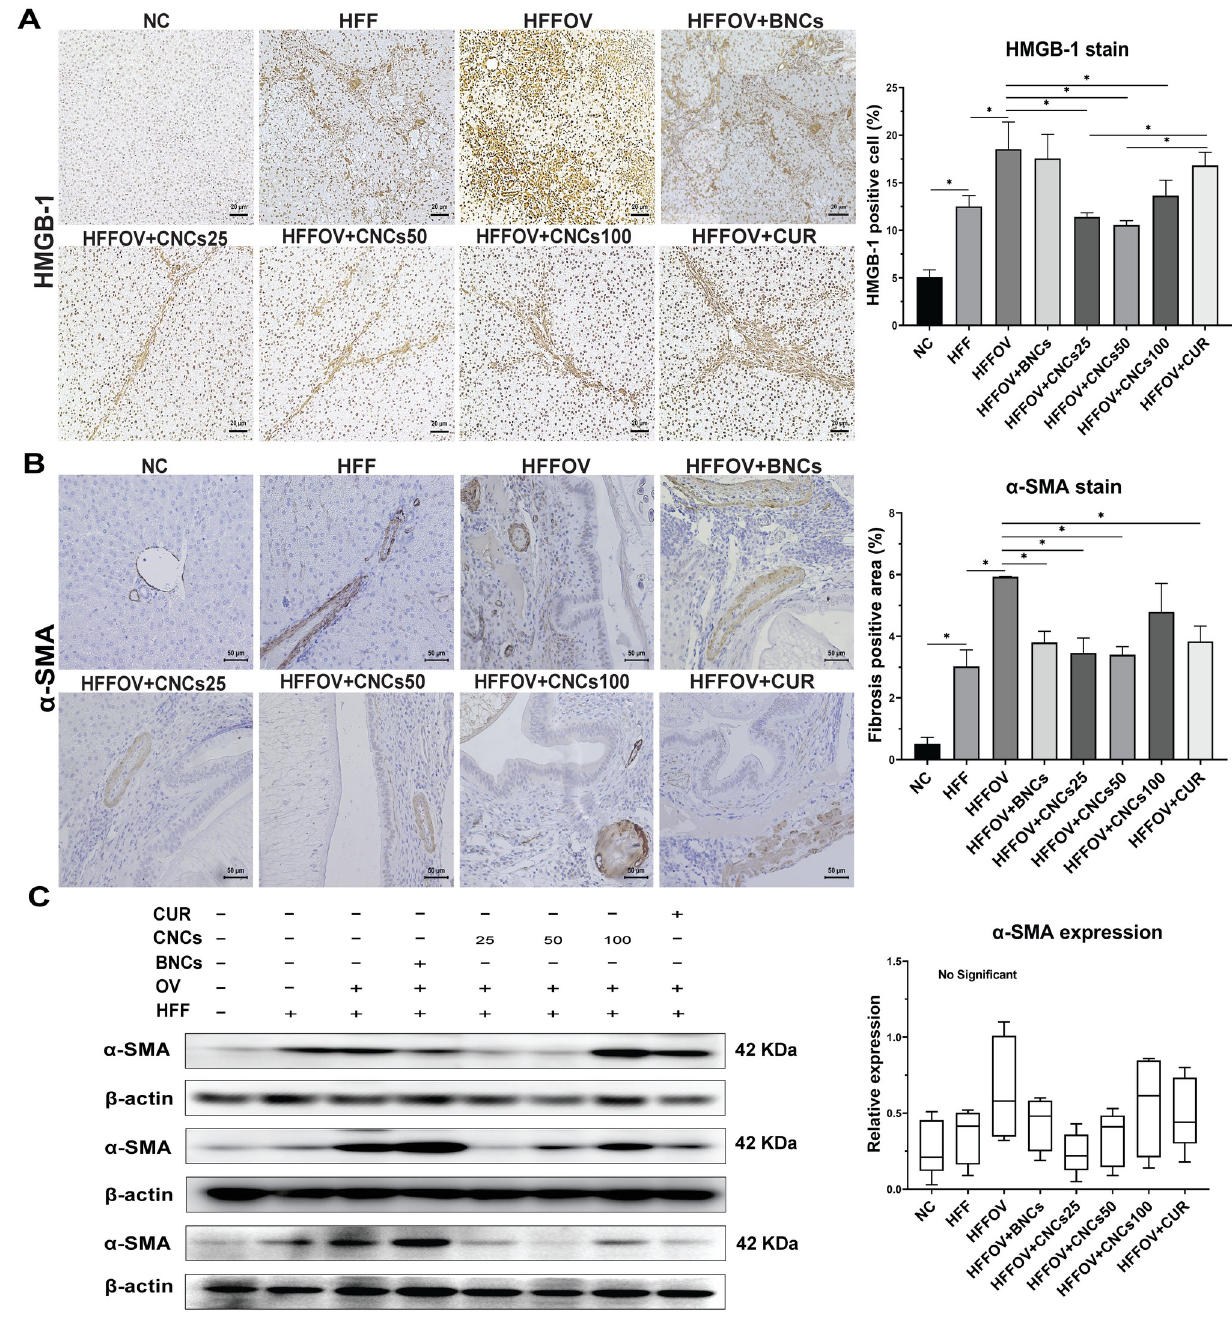
Fig 6. Effect of treatment with CNCs on inflammation and fibrosis in hamsters infected with O . viverrini and fed an HFF diet. A): Images show immunohistochemical staining (original magnification × 100) for HMGB–1 on the left and a graph of intensity of cell inflammation (assessed at 200x magnification) on the right. B): Images show immunohistochemical staining (original magnification × 200) for α –SMA on the left and a graph of intensity of cell inflammation (assessed at 200x magnification) on the right. C): Protein expression of α -SMA by western blot and quantitative analysis was normalized by β -actin from different individual hamsters. Results are presented as mean ± SD. Statistical analyses were done using one-way ANOVA � P < 0.05 (Tukey’s multiple comparisons test) (n = 4–5 in each group). Abbreviations are the same as in Fig 3 legend.